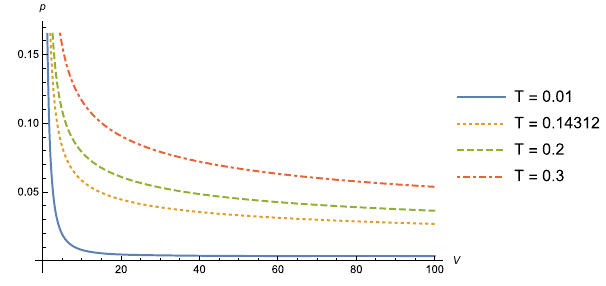
Fig. 5 Graphs p x V for different values of T . We assumed that Q = M = 1 e a = 0 . 1